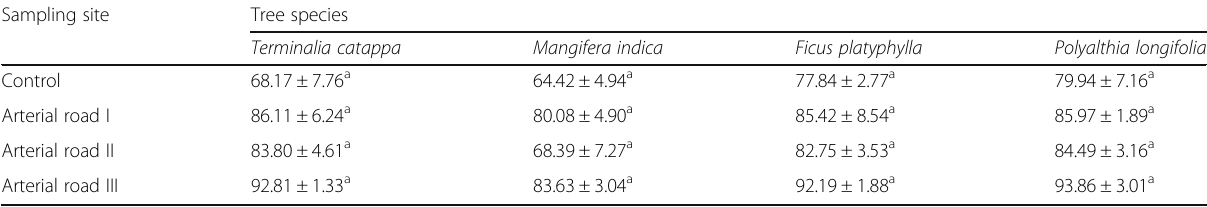
Table 4 Effect of vehicular air pollution on relative water content (%) of four street tree species in the Kumasi Metropolis Sampling